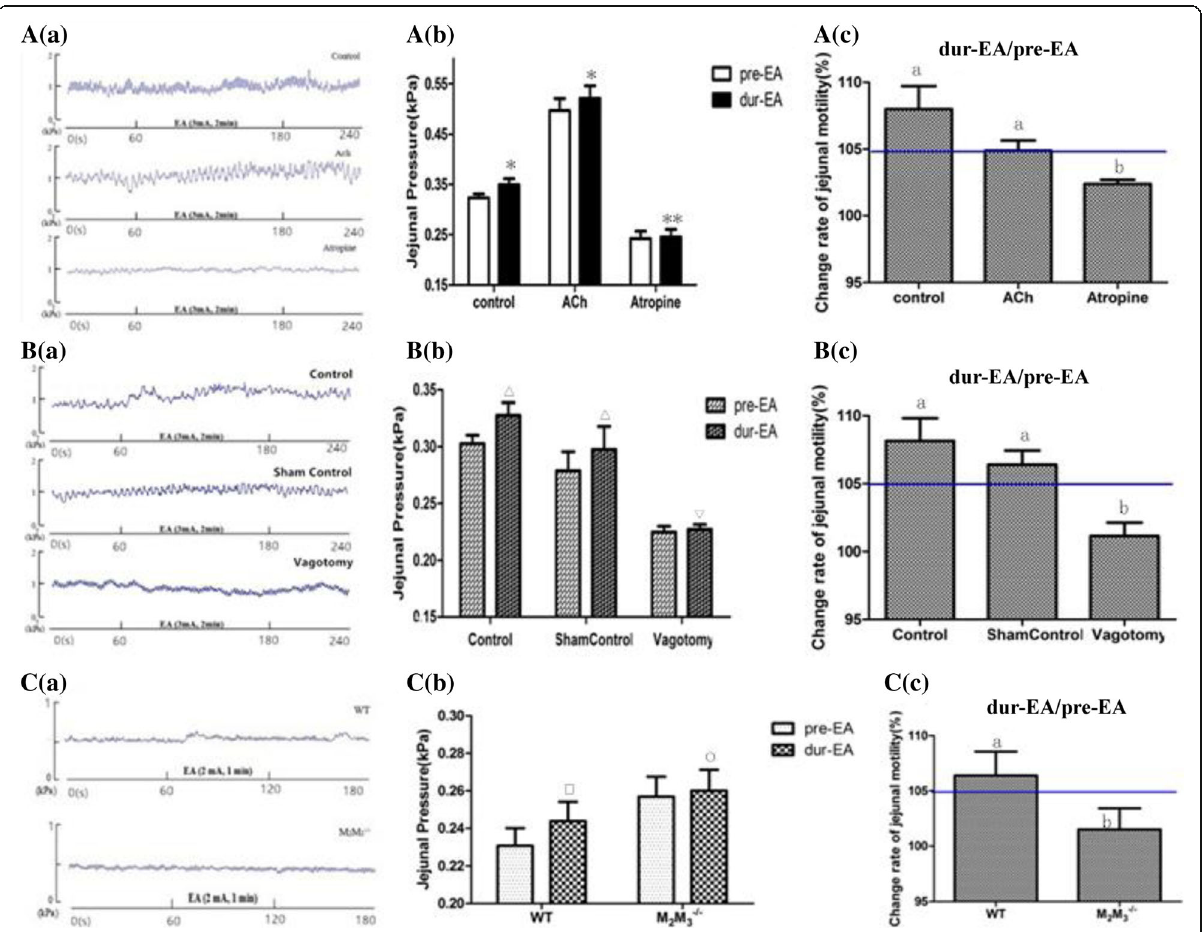
Fig. 4 Jejunal motility in response to EA at LI11 under the administration of the parasympathetic pathway. Aa Representative tracings of jejunal motility regulated by EA, EA with the administration of ACh and atropine in rats. Ab Compared with the jejunal pressure before EA, changes were observed during EA in the control group and ACh group, but EA at LI11 failed to enhance jejunal pressure in the atropine group. Data are expressed as mean ± SEM ( n = 8 rats per group at each period). △ P < 0.05 vs pre-EA, # P > 0.05 vs pre-EA, paired t -test. Ac Promotion percentages of jejunal pressure from EA in the atropine group was below 105%, and were significantly lower than the other two groups. Data are expressed as mean ± SEM ( n = 8 rats/mice). a P < 0.05 vs control group, Ach group, b P > 0.05 vs control group, Ach group, One-way ANOVA. Ba Representative tracings of jejunal motility regulated by EA, EA with the vagotomy, sham operation in rats. Bb Compared with the jejunal pressure before EA, changes were observed during EA in the control group and sham control group, but EA at LI11 failed to enhance jejunal pressure in the vagotomy group. Data are expressed as mean ± SEM ( n = 8 rats per group at each period). △ P < 0.05 vs pre-EA, ▽ P > 0.05 vs pre-EA, paired t -test. Bc Promotion percentages of jejunal pressure from EA in the vagotomy group was below 105%, and were significantly lower than the other two groups. Data are expressed as mean ± SEM ( n = 8 rats/mice). a P < 0.05 vs control group, Ach group, b P > 0.05 vs control group, Ach group, One-way ANOVA. Ca Representative tracings of jejunal motility regulated by EA in WT mice and M 2 M 3 − / − mice. Cb Compared with the jejunal pressure before EA at the same intensity, the jejunal pressure in the WT group was enhanced with EA at LI11, but no impact was demonstrated in the M 2 M 3 − / − group. Data are expressed as mean ± SEM ( n = 8 mice per group at each period). * P < 0.05 vs pre-EA, ○ P > 0.05 vs pre-EA, paired t -test. Cc Promotion percentages of jejunal pressure from EA in the M 2 M 3 − / − group were below 105%, and was significantly lower than the WT group. Data are expressed as mean ± SEM ( n = 8 rats/mice). a P < 0.05 vs WT group, b P > 0.05 vs WT group, One-way ANOVA. EA, electroacupuncture; ACh, acetylcholine; WT,